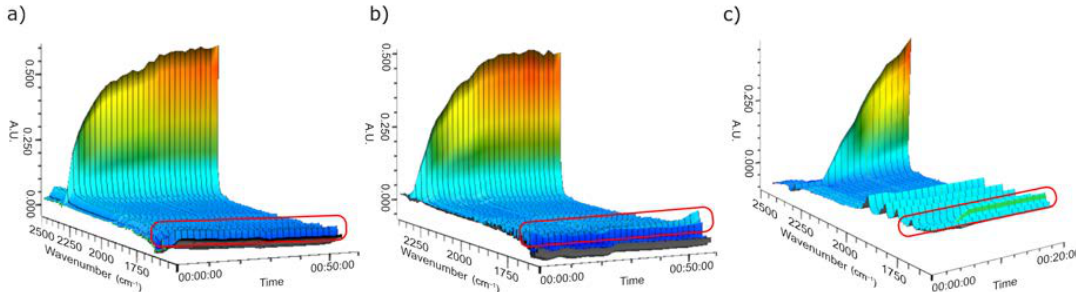
Figure 5. In situ IR spectroscopic measurements of the reaction of CO 2 and ( a ) Ce( t Bu 2 pz) 4 ( 1 ), ( b ) Ce(Ph 2 pz) 4 ( 2 ), and ( c ) Ce( t BuMepz) 4 ( 3 ) at − 20 ◦ C. The wavenumber of the C=O band is marked with a red box.